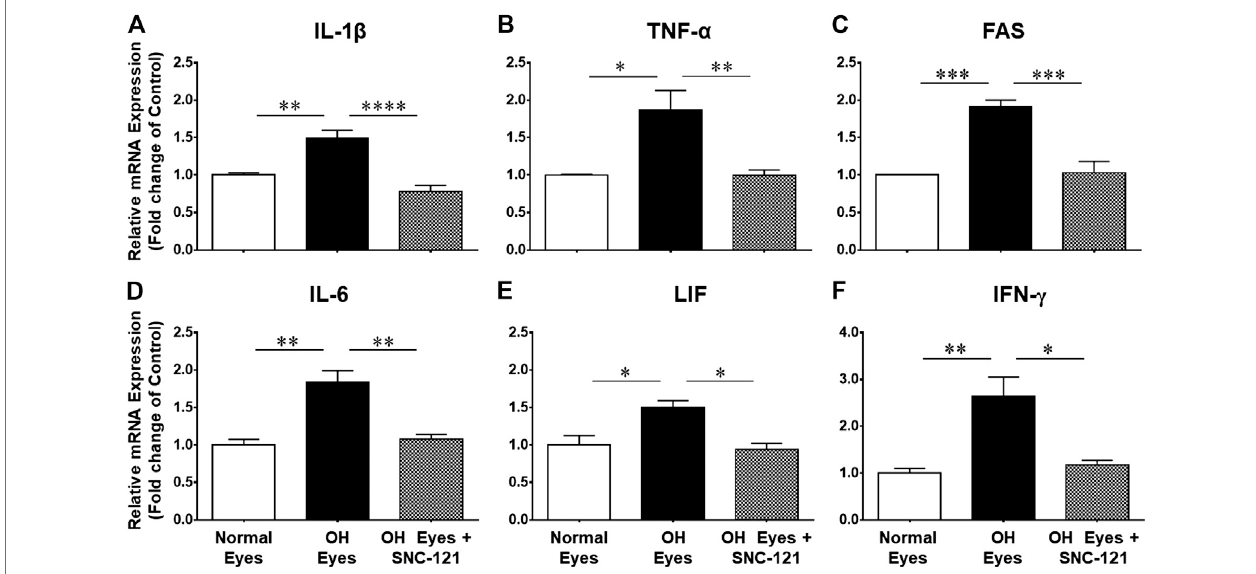
FIGURE 1 | Changes in mRNA expression of pro-in fl ammatory cytokines in response to ocular hypertension and SNC-121 treatment. Intraocular pressure (IOP) was raised by 2.0 M hypertonic saline injection followed by δ -opioid receptor agonist (1 mg/kg; i. p injections) treatment for 7 days, once a day. The retinas were collected at day 7, post hypertonic saline injection and mRNA was analyzed for IL-1 β (A) , TNF- α (B) , FAS (C) , IL-6 (D) , LIF (E) , and IFN- γ (F) using cDNA that was synthesized from 1 µg total RNA. The relative changes in mRNA levels were measured by quantitative RT-PCR (qRT-PCR) using primers speci fi c for each gene as indicated in Table 1 . The qRT-PCR data was normalized using ß -actin gene expression as an internal control. The relative expression was calculated based on the comparative threshold cycle (2 − ΔΔ Ct ) method. Bar graph represents mean data ± SEM. OH Eyes; ocular hypertensive eyes; OH Eyes + SNC-121, ocular hypertensive